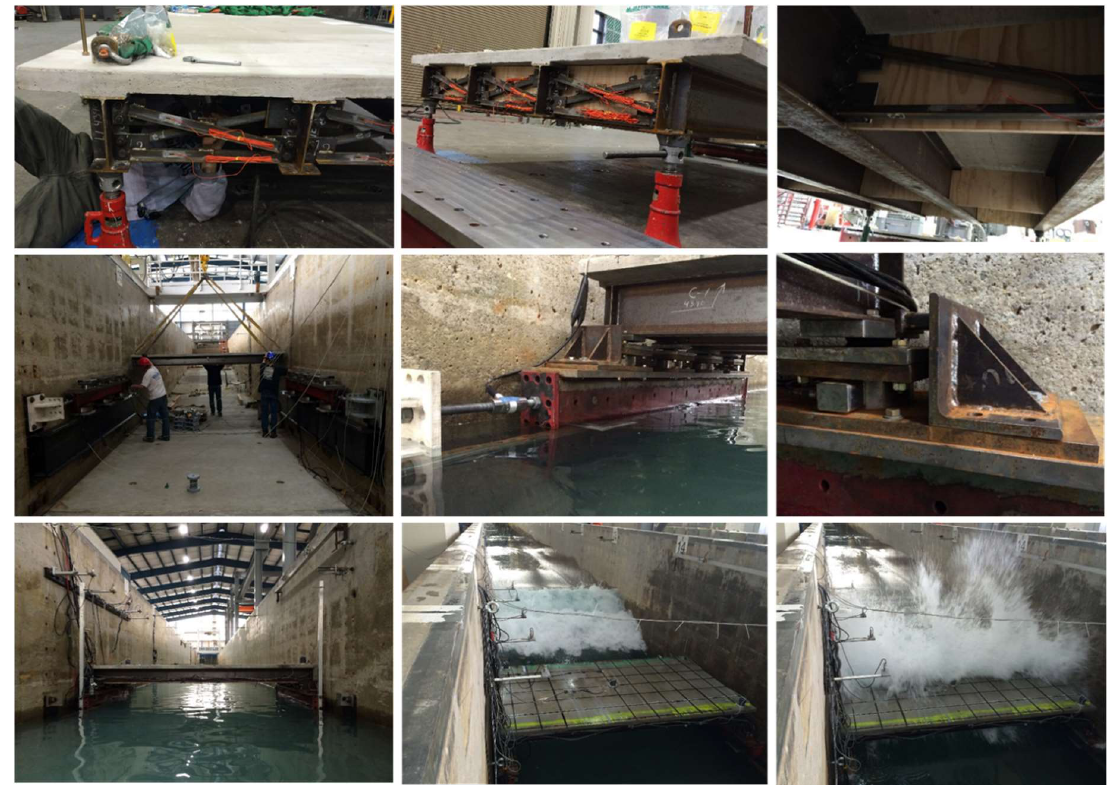
Figure 2. Bridge deck with cross-frames and diaphragms during the dry pre-test assembly in the Large-Scale Structures Laboratory at the University of Nevada, Reno ( top ), the set-up in the wave flume ( center ), and the hydrodynamic testing ( bottom ).